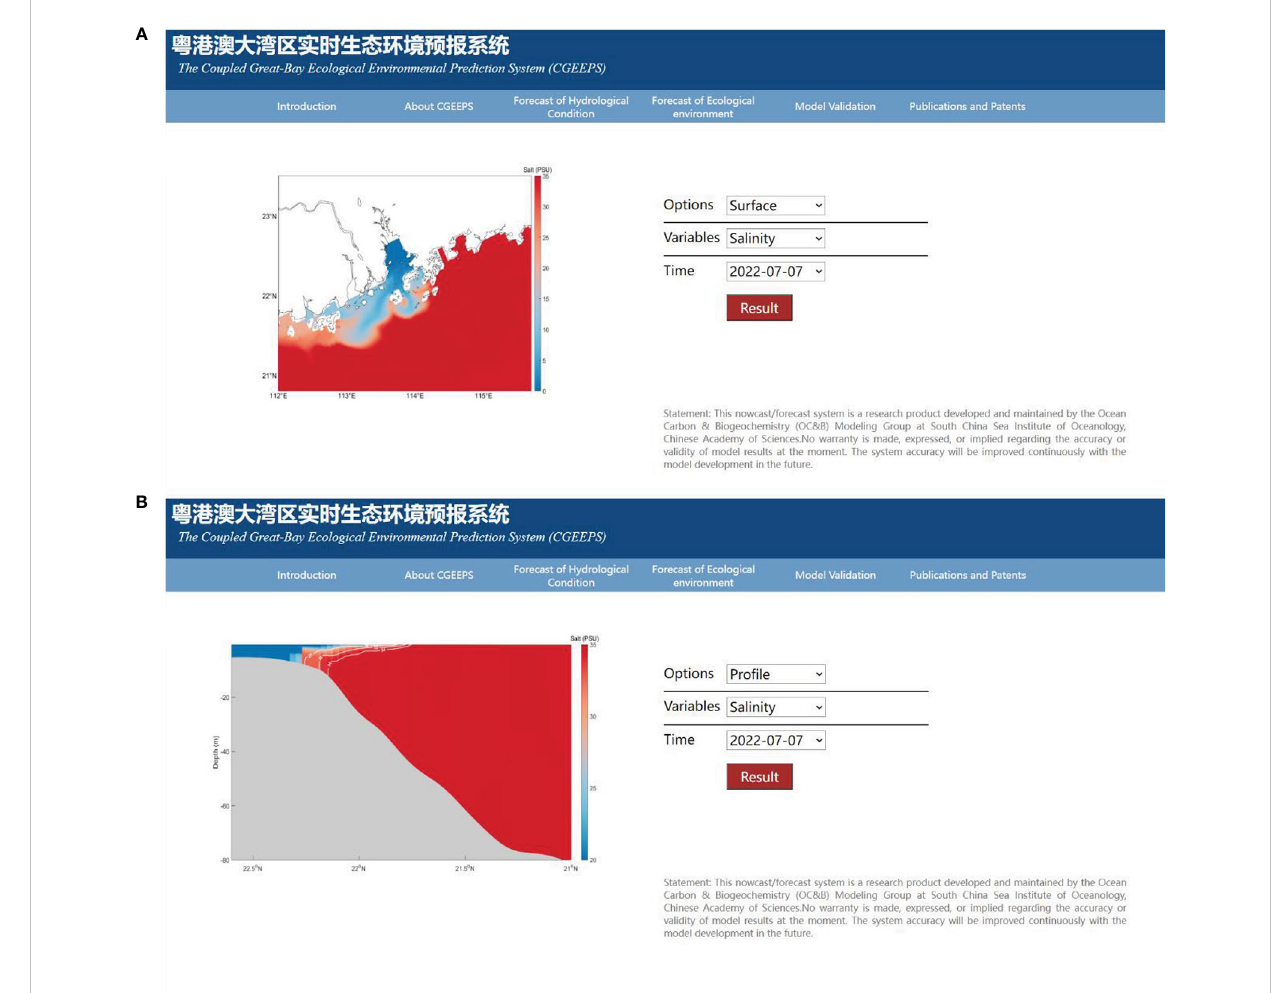
FIGURE 14 Real-time graphics displaying the surface (A) and vertical transect (B) of salinity (Screen shot from July 07,